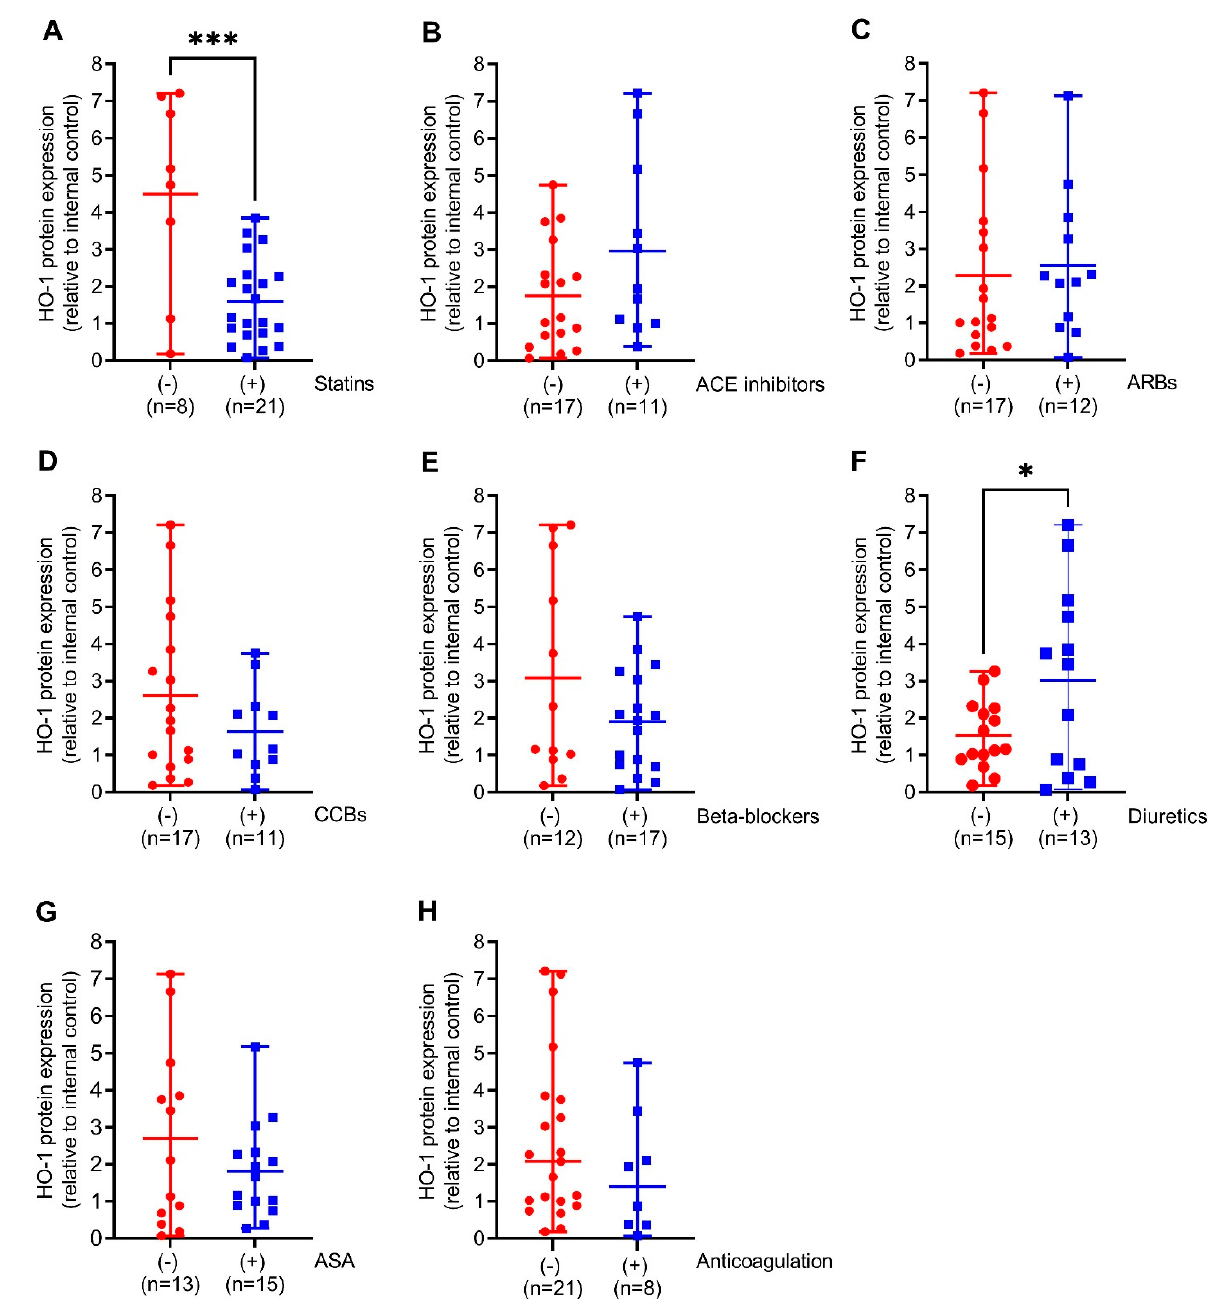
Figure 3. Comparison of HO-1 protein expression in response to different pharmacological therapies in aortic tissues obtained from patients undergoing open surgical repair due to AAA. ( A – H ) Protein expression was measured by Western blot, and results were divided into patients receiving the indicated therapy (+, blue) or not ( − , red). ( A ) 70 kDa band obtained after Ponceau S staining served as the loading control, and data were normalized to an internal control (=1). Statistics: Significant outliers were detected by Grubb’s outlier test and were removed from all further analysis. ( B ) One significant outlier was removed from the ( − ) group. ( D , F ) One significant outlier was removed from the (+) group. Data are presented as scatter dot plots, where the horizontal line depicts the mean or median with range depending on normality testing. ( A – F ), Unpaired t -test. ( G , H ) Mann–Whitney U test. * p < 0.05 ( − ) vs. (+) diuretics. *** p < 0.001 ( − ) vs. (+) statins. Abbreviations: ACE, angiotensin- converting enzyme; ARB, angiotensin II receptor blockers; ASA, acetylsalicylic acid; CCB, calcium channel